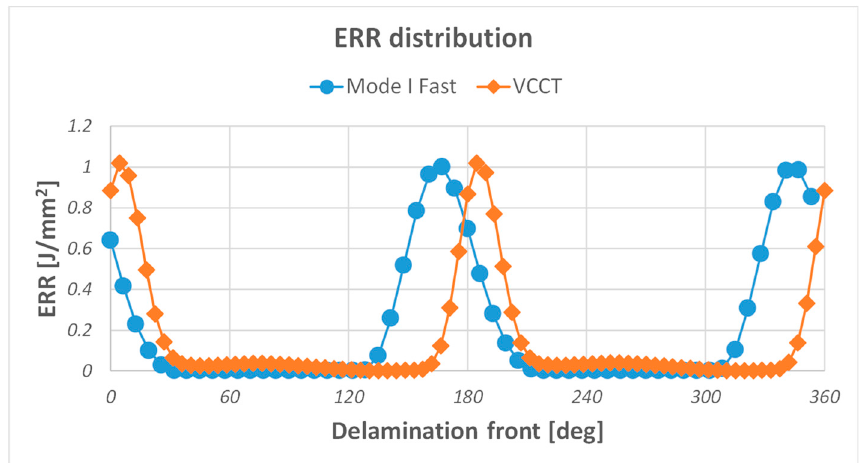
Figure 10. Influence of the element discretization in the tangential direction on the critical propagation strain.